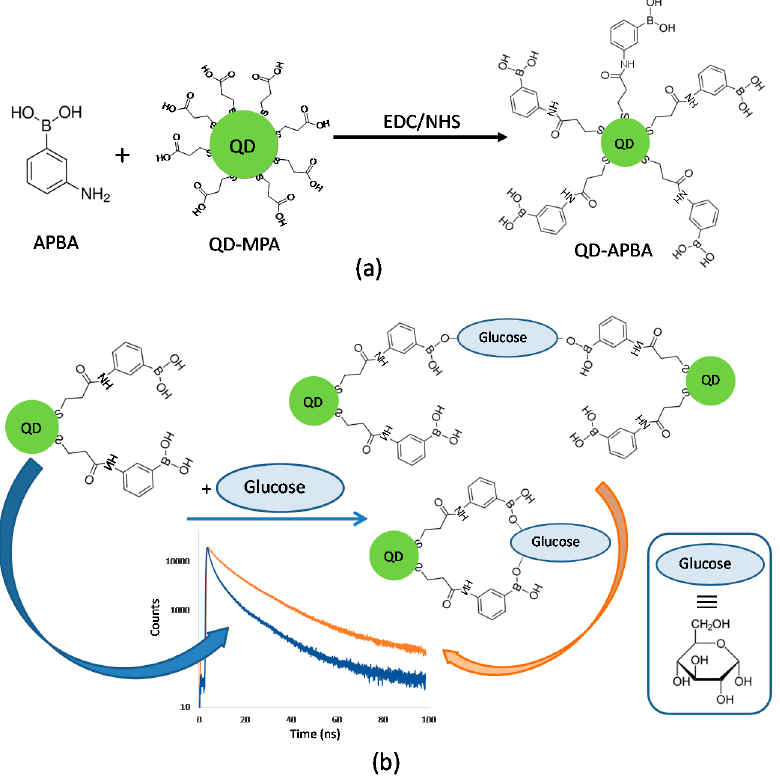
Figure 1. ( a ) Scheme of the covalent coupling reaction for the synthesis of the QD-APBA (quantum dot–aminophenylboronic acid) conjugates. ( b ) Scheme of the proposed mechanism of response of the QD-APBA conjugates toward glucose.